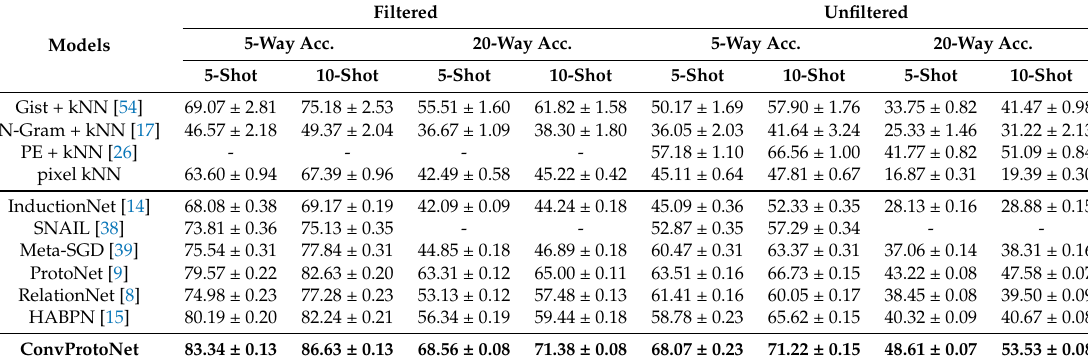
Table 1. Test accuracy and 95% confidence interval for malware few-shot classification on LargePE dataset. Bold items indicate the highest accuracy among all models under the same experiment